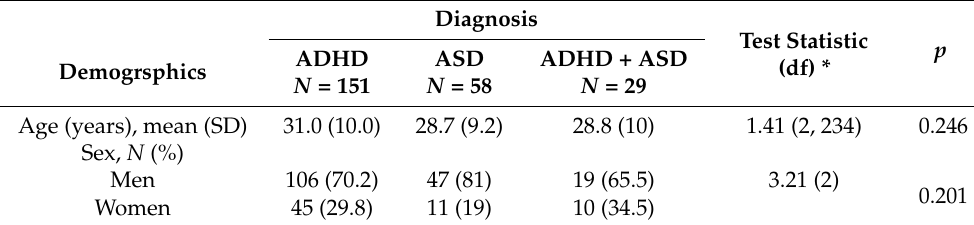
Table 1. Sample characteristics by